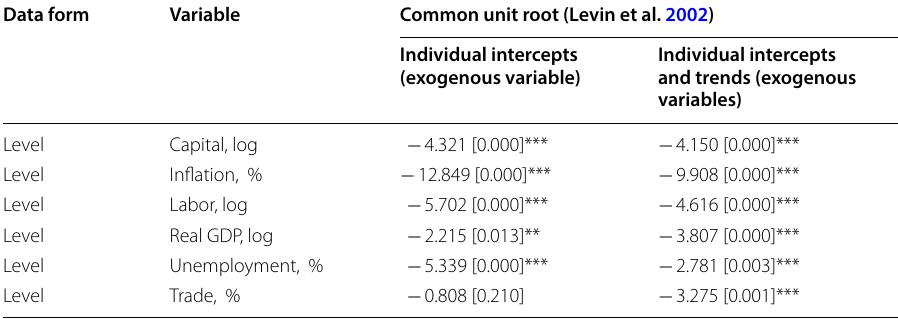
Table 2 Panel unit-root tests